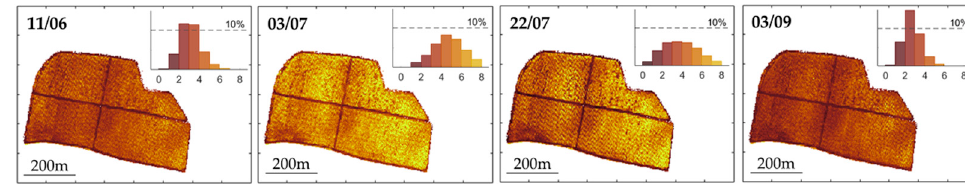
Figure 6. Daily evapotranspiration (in mm d − 1 ) maps and histograms for the main experimental area.